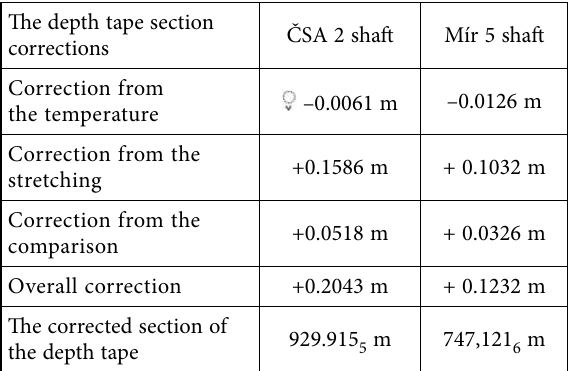
Table 3. Calculated corrections of systematic errors in the depth tape section – ČSA 2 shaft and Mír 5